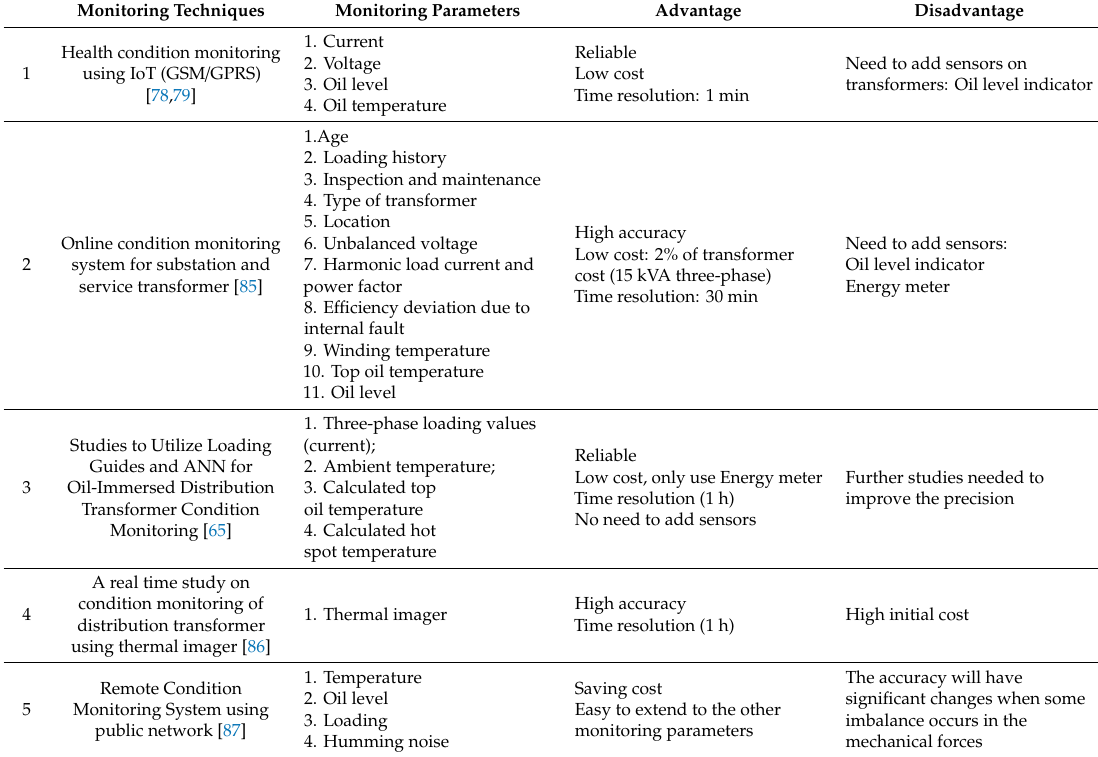
Figure 6. The flowchart of the monitoring systems. Table 5. Literature